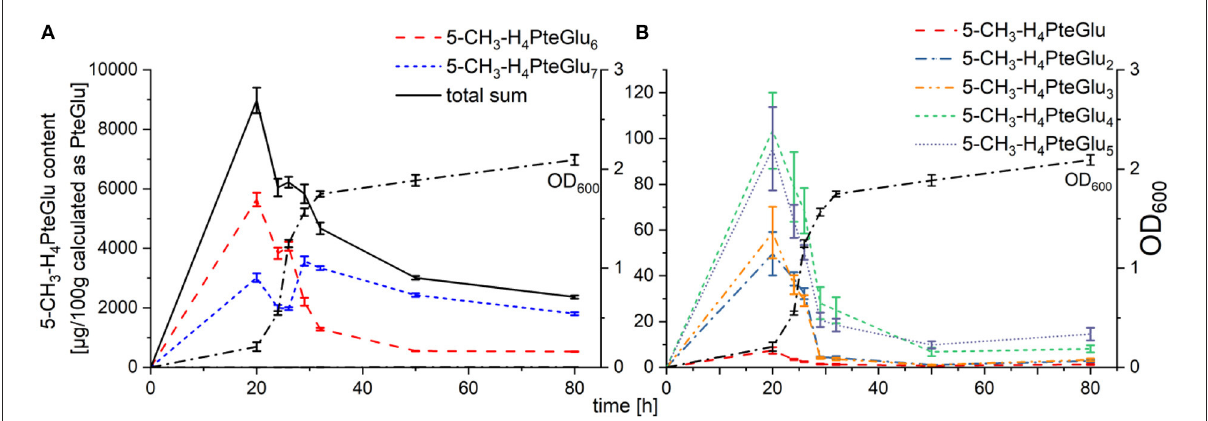
FIGURE3 Folate contents of the polyglutamates 5-CH 3 -H 4 PteGlu 1 − 7 in TUM68 ® yeast during cultivation, calculated as µ g/100g PteGlu; with (A) main polyglutamates 5-CH 3 -H 4 PteGlu 6 (red), 5-CH 3 -H 4 PteGlu 7 (blue), and the total sum of 5-CH 3 -H 4 PteGlu 1 − 7 (black) in comparison to the optical density (OD 600 , dotted line), (B) minor polyglutamates 5-CH 3 -H 4 folate (red), 5-CH 3 -H 4 PteGlu 2 (blue), 5-CH 3 -H 4 PteGlu 3 (orange), 5-CH 3 -H 4 PteGlu 4 (green), and 5-CH 3 -H 4 PteGlu 5 (purple) in comparison to the optical density (OD 600 , dotted line). Data are expressed as mean values ± confidence limits.